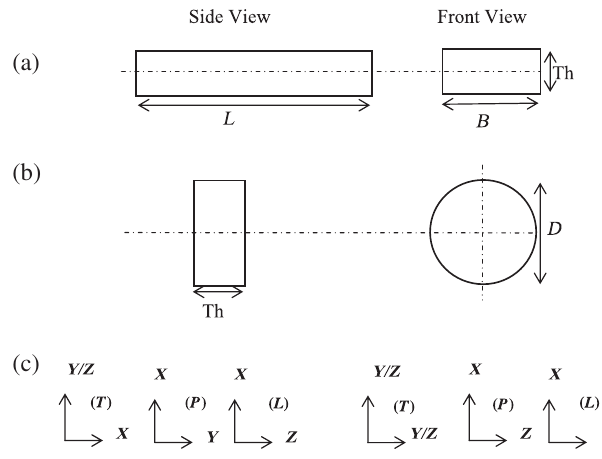
FIG. 3. Schematic experiment of (a) rectangular, (b) cylindrical specimen geometries, and (c) corresponding orthogonal coordi- nate system with X , Y , and Z representing transversal ( T ), perpendicular ( P ), and longitudinal ( L ) orientations,